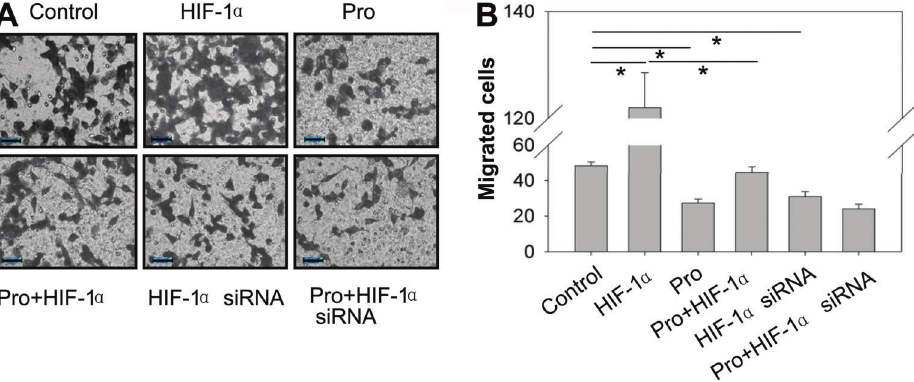
Figure 5. Overexpressed hypoxia inducible factor-1 a (HIF-1 a ) hemangioma cells and knockdown hemangioma cells were treated or not with 50 m M propranolol (Pro) for 48 h. Cell migration was measured by transwell system. A , Representative images of cells migration (200 (cid:1) magni fi cation). B , Quanti fi ed values of migrated cells in each group. Data are reported as means ± SD of 3 random fi elds. All treatments were performed in triplicate. *P o 0.05